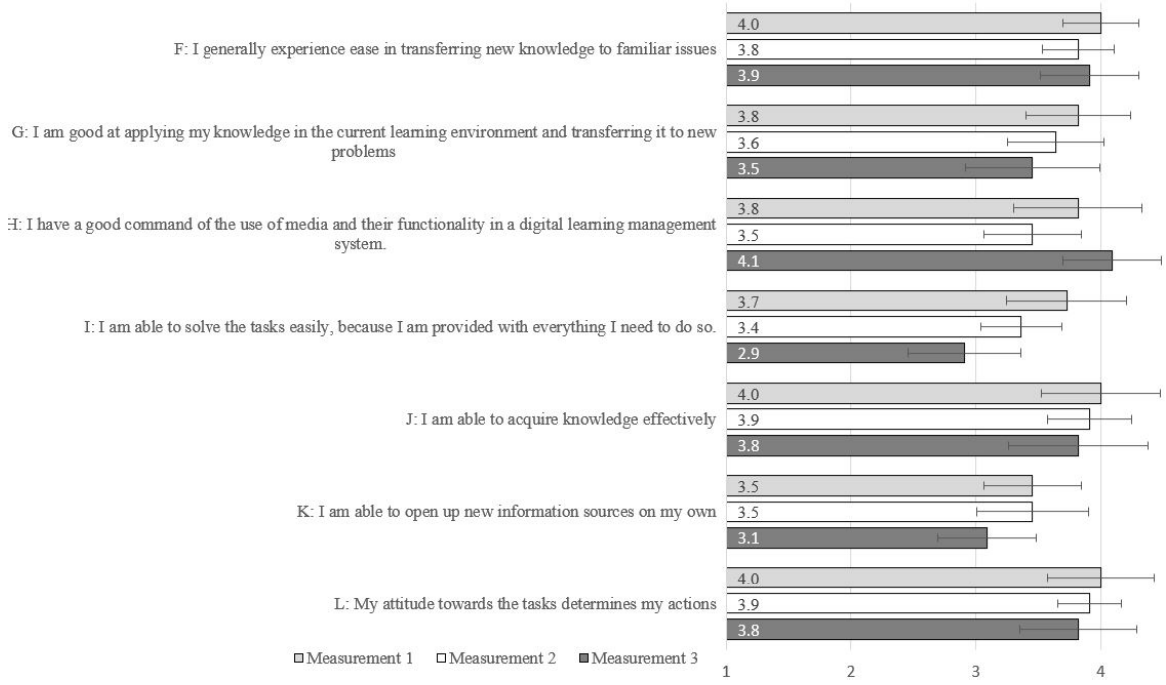
Figure 4. Items regarding learning and measurements ( n = 11).